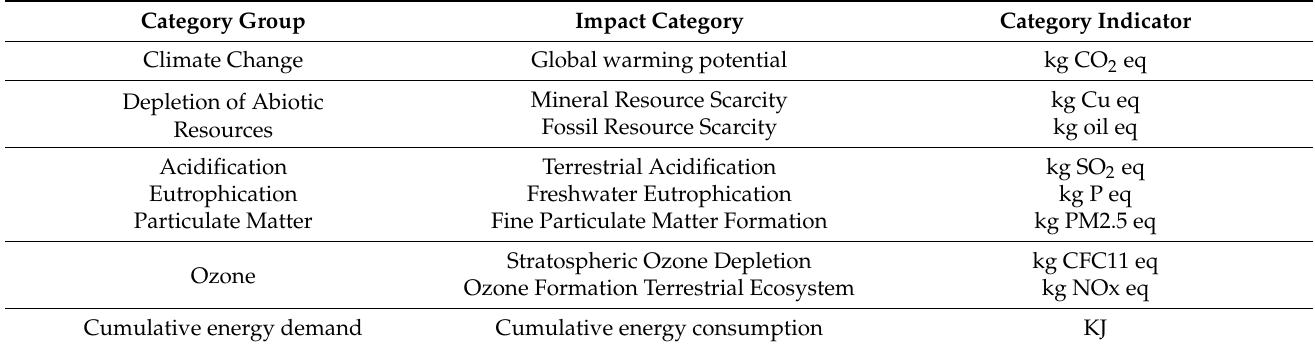
Table 7. Different Impact categories selected from